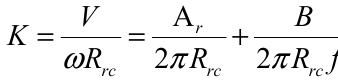
and r − 1 wind speed are